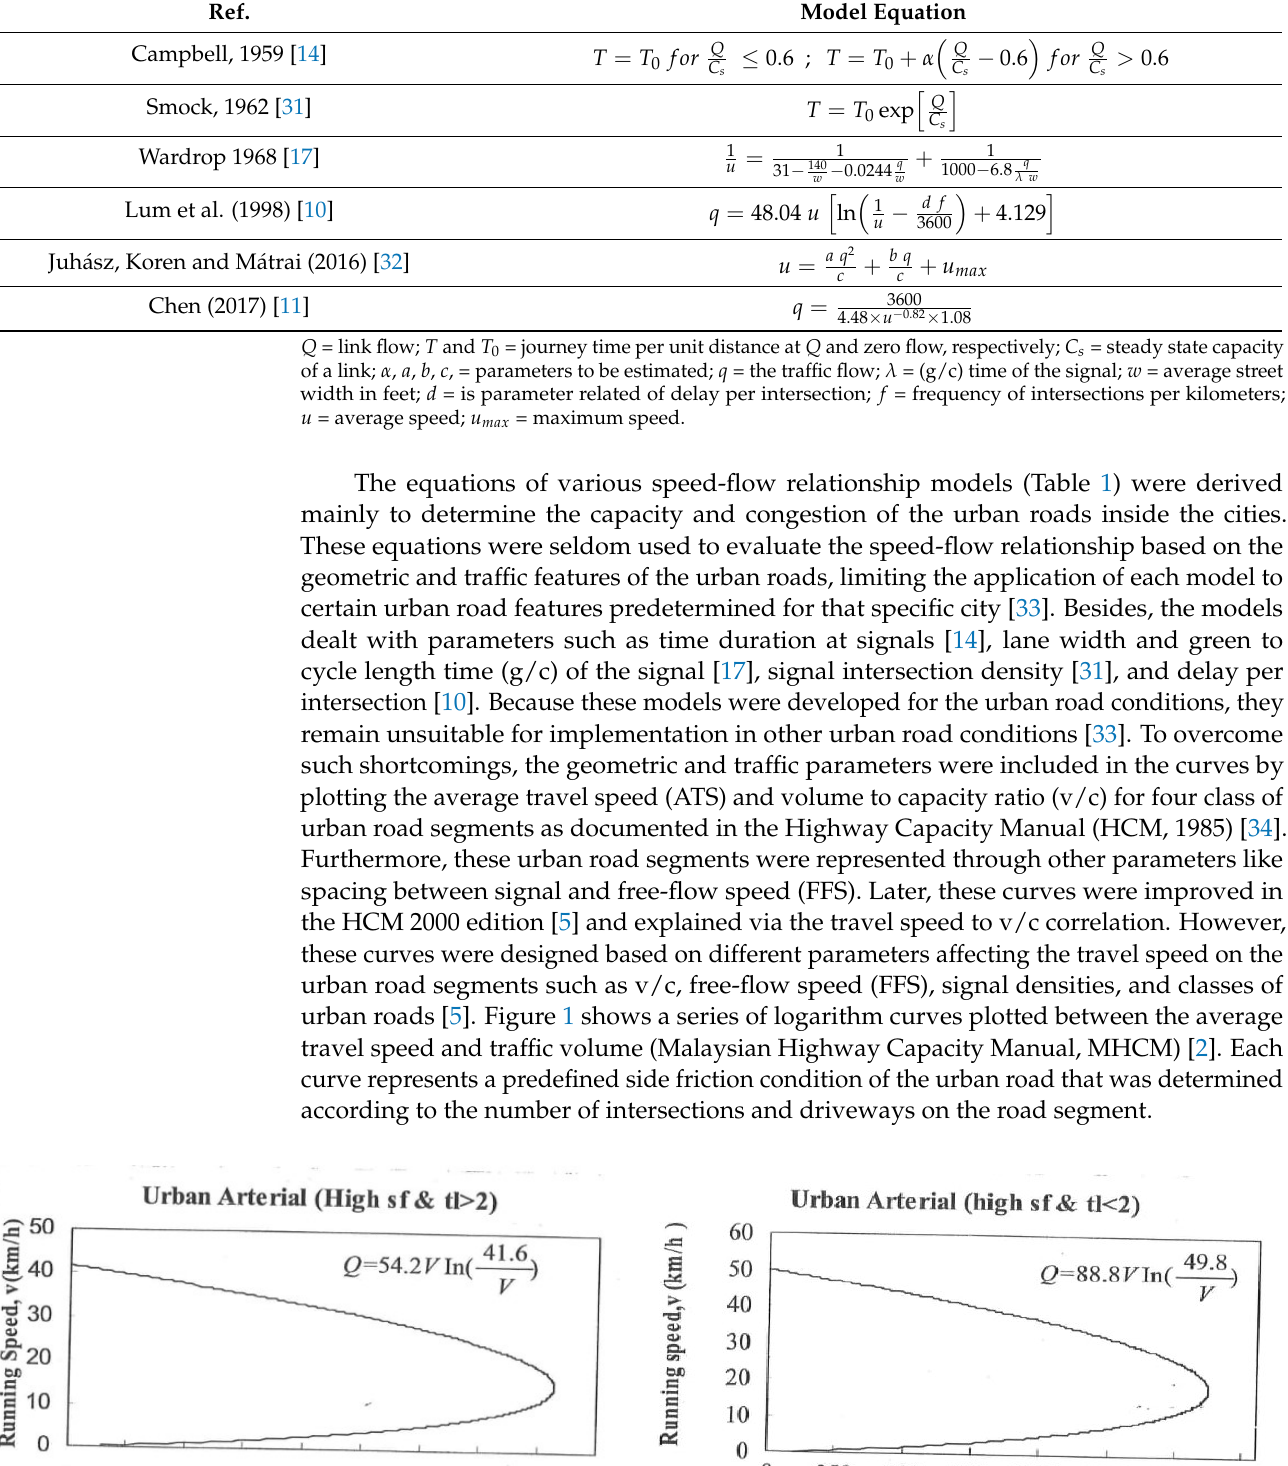
Table 1. Equations of various speed-flow relationship models for the urban roads network. Ref.